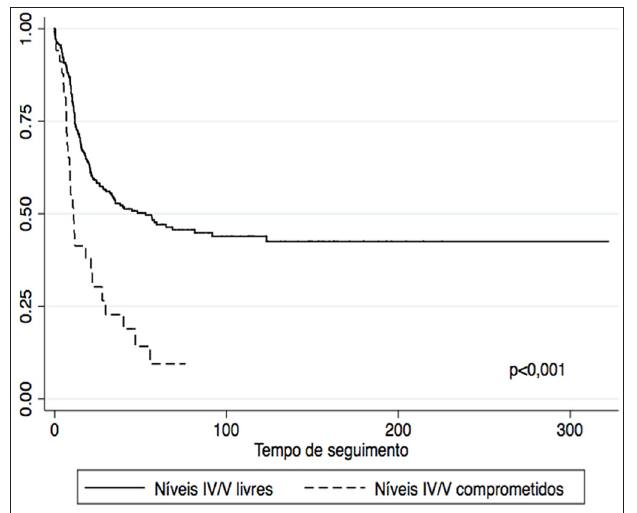
Figura 1. Função de sobrevivência de Kaplan-Meier para pacientes com e sem linfonodos metastáticos em nível IV/V.